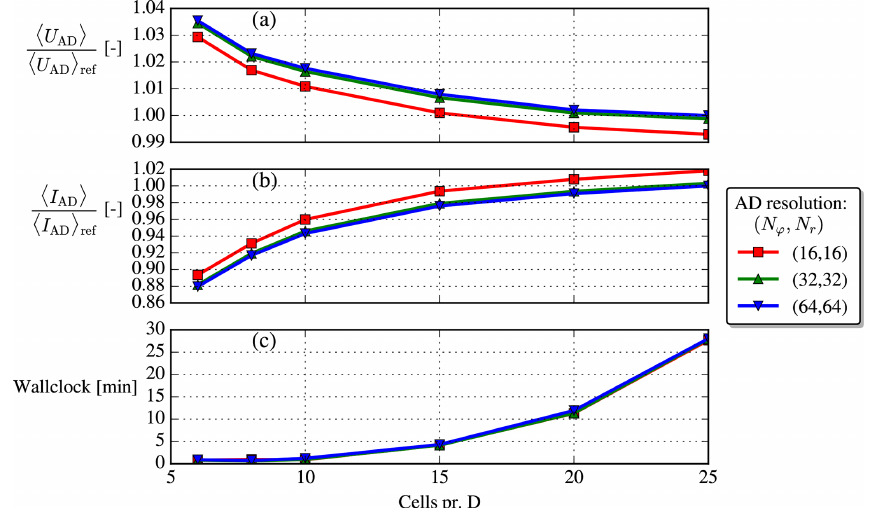
Figure A1. Grid-independence study. “Ref” means reference, i.e., the finest resolution available. Metrics are evaluated at x/D = 1. The cores used for the increasing domain resolutions are { 45, 54, 63, 54, 60, 57 } , respectively (non-constant because the domains are decomposed in different number of